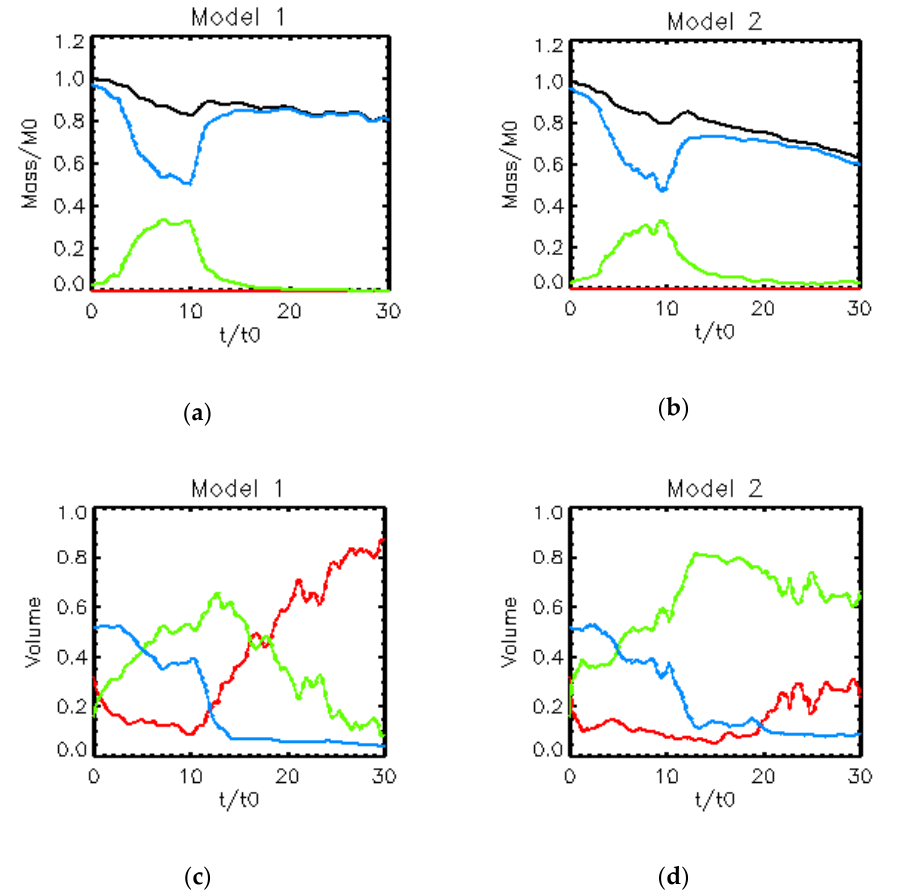
Figure 7. Time evolution of mass and volume of Model 1 and Model 2. Results are obtained by the integration in the domain of 0 < r / R 0 < 2, 0 < ϕ < 2 π and − 1 < z / R 0 < 1 except for the region √ r 2 + z 2 / R 0 < 0.3. These are normalized by initial total mass and volume of the above domain, respectively. ( a ) Model 1. Blue line shows the mass of gas whose temperature range is T / T 0 < 0.1. Green line shows the mass of 0.1 < T / T 0 < 10. Red line shows the mass of 10 < T / T 0 . Black line shows sum of three components. ( b ) Model 2. Same as ( a ). ( c ) Model 1. Time evolution of volume of each temperature range same as ( a ). Colors mean same as ( a ). ( d ) Model 2. Same as ( c ).